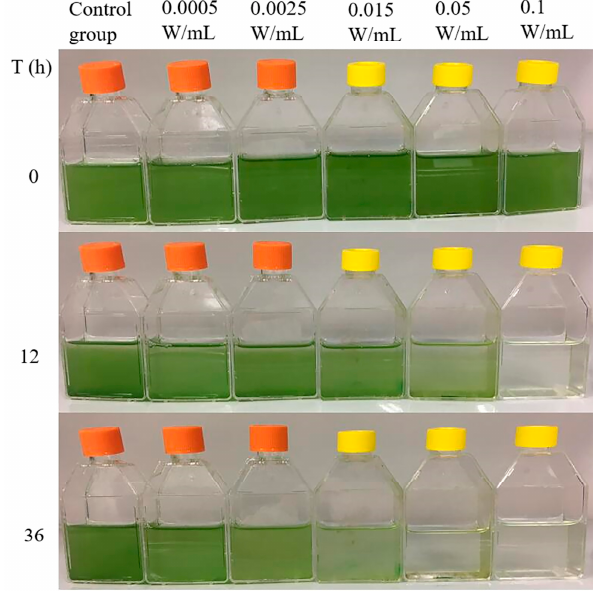
Figure 5. Growth of M. aeruginosa after treatment at different ultrasonic densities. The removal rates at ultrasonic densities of 0.0005, 0.0025, 0.015, 0.05 and 0.1 W / mL were 40.6%, 58.0%, 81.2%, 92.0% and 92.8% 48 h after ultrasonic irradiation, respectively, when all other factors were held constant. The removal rate increased with the increasing radiation density in this